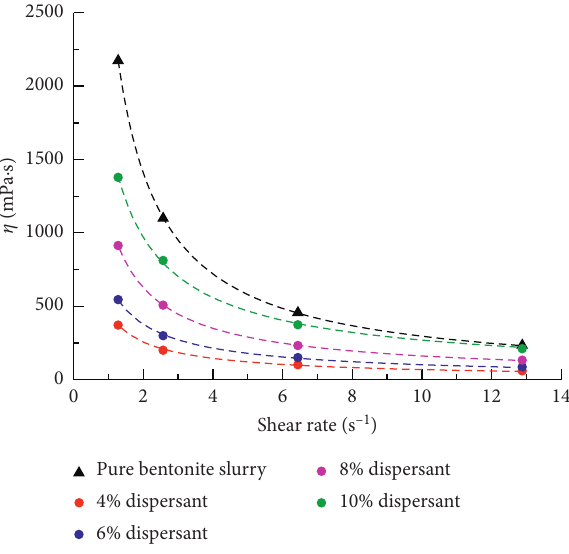
Figure 5: Slurry viscosity